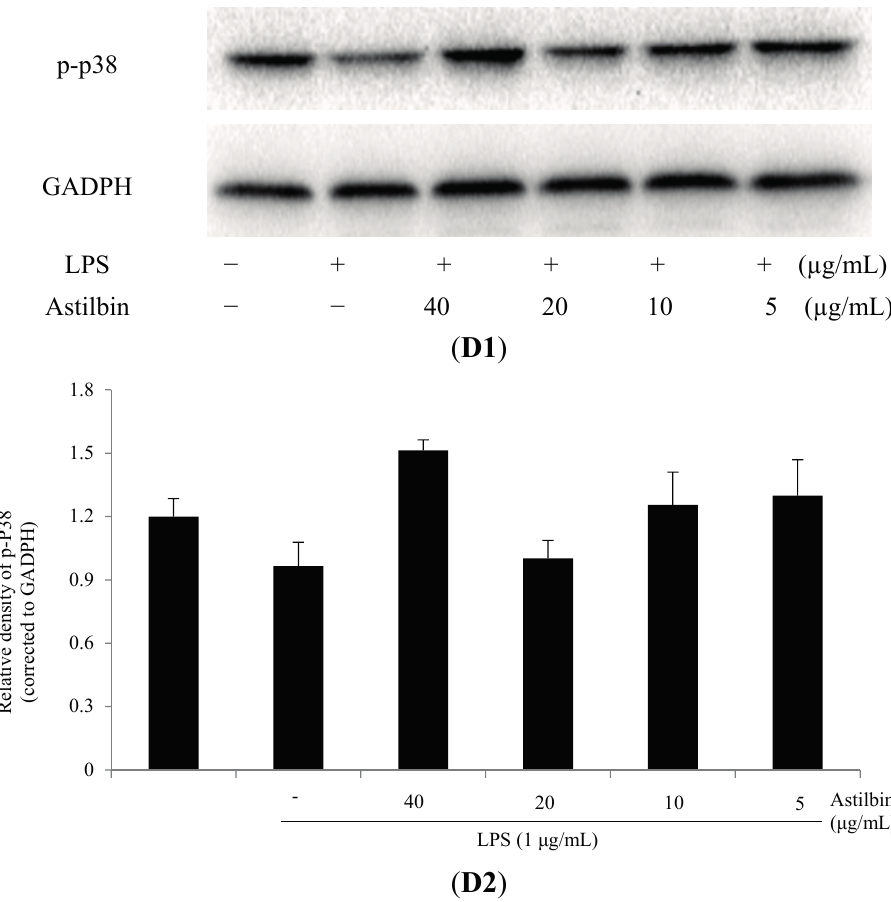
Figure 4. Effects of astilbin on NF- κ B and MAPK pathways in LPS-induced RAW264.7 macrophages. Cells were incubated with different concentrations of astilbin (5, 10, 20, and 40 µg/mL) for 1 h before exposure to LPS (final concentration 1 µg/mL) for 1 h. Protein was extracted and analyzed using western blotting. One of three experiments is shown. The protein levels were normalized to the levels of GAPDH. ( A ) Effect of astilbin on the phospho-p65, ( B ) effect of astilbin on the phospho-ERK1/2, ( C ) effect of astilbin on the phospho-JNK, ( D ) effect of astilbin on the phospho-p38 MAPK. The data were represented as the mean ± SD (n = 3). ## p < 0.01 compared to the control group, while * p < 0.05 and ** p < 0.01 compared to LPS-treated